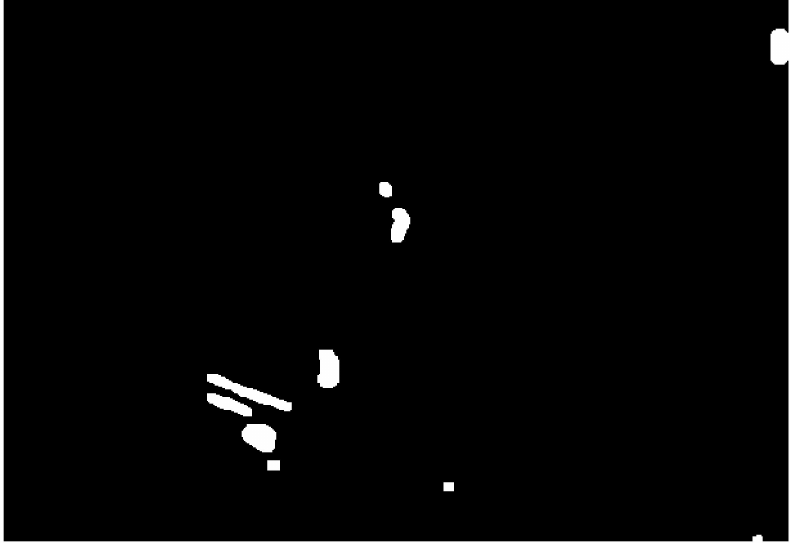
Figure 18. Calcium in the binarized